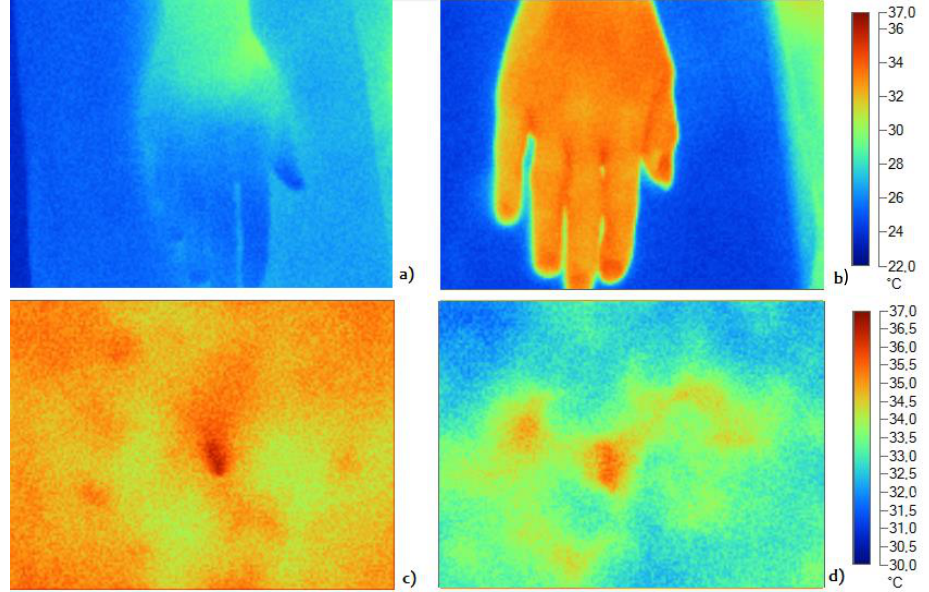
Figure 1. Example of an IRT image of hand and abdomen of a lean ( a , c ) and an overweight ( b , d ) subject at rest. Hand temperature is higher in the overweight subject compared to the lean subject, while abdominal temperature is higher in the lean